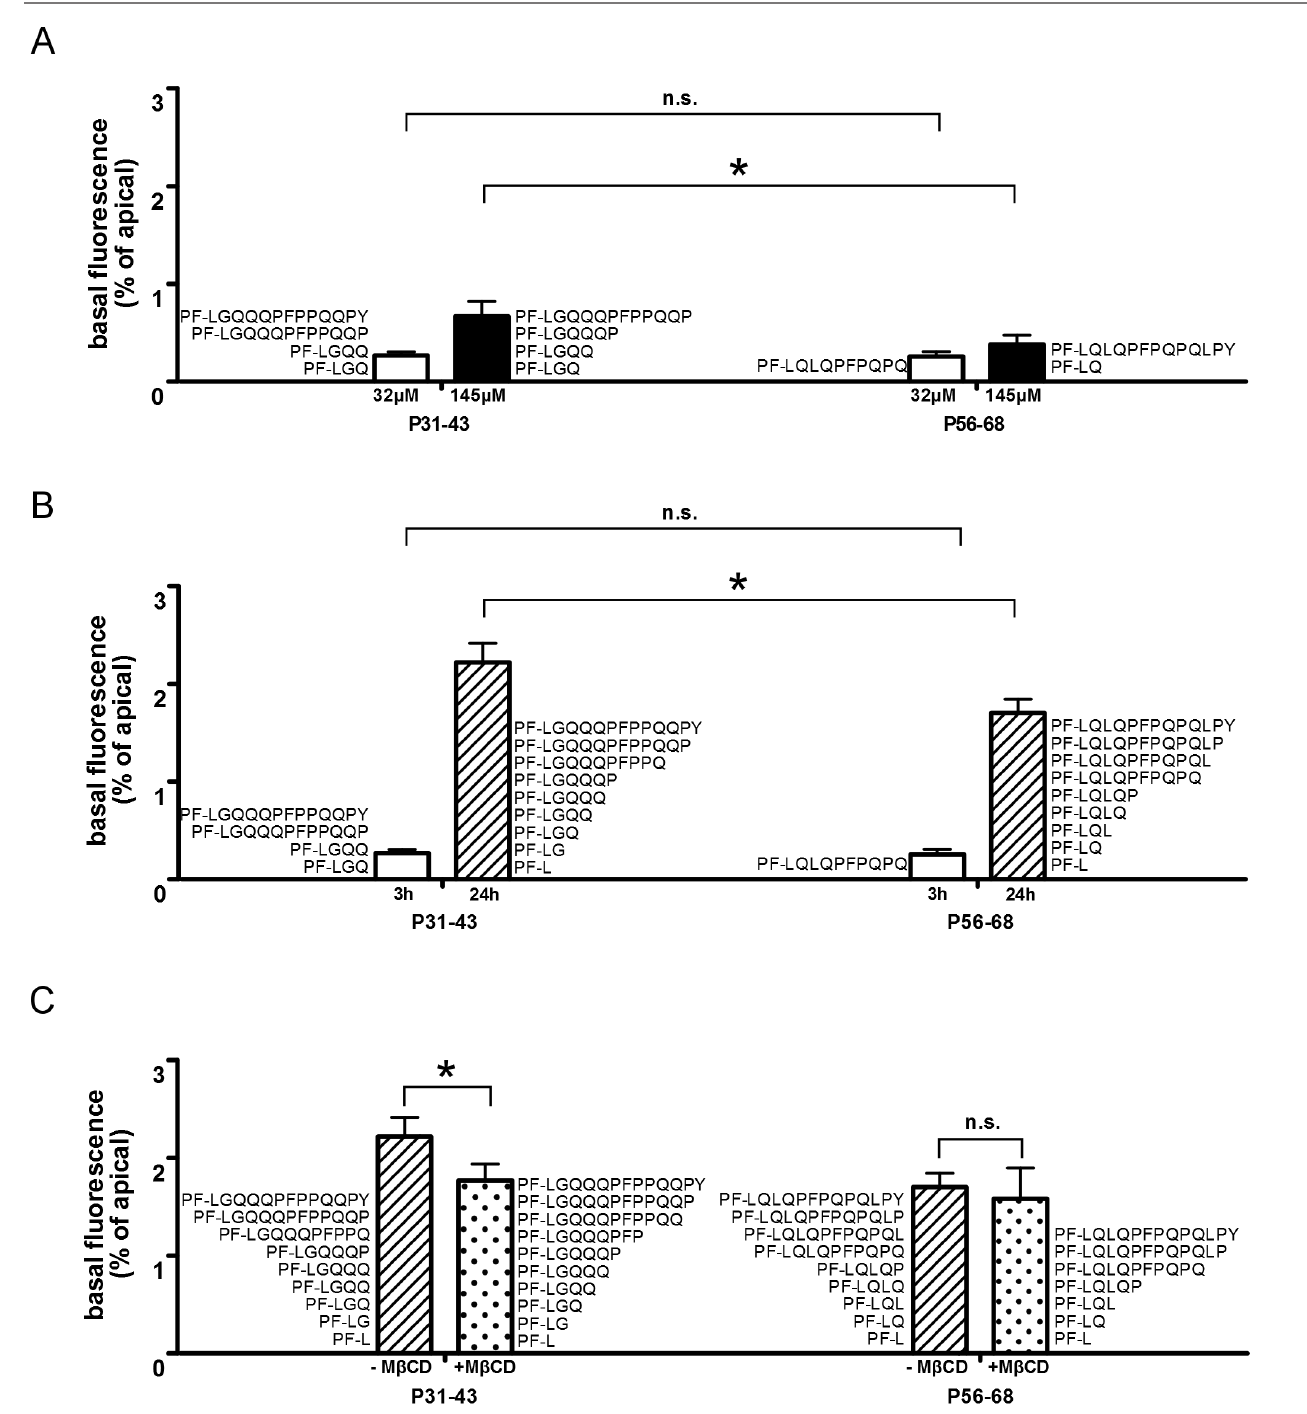
Figure 2. Epithelial translocation in Caco-2 monolayers of fluorescence labeled gliadin peptides measured by fluorescence spectroscopy and MALDI-TOF-MS. Fluorescence intensity and mass spectrometric identified peptides in the basal cell culture media (A) after incubation with fluorescence labeled P31–43 and P56–68 (32 m mol/L and 145 m mol/L) for 3 h, (B) after incubation with 32 m mol/L fluorescence labeled P31–43 and P56–68 for 3 h and 24 h, (C) after incubation with 32 m mol/L fluorescence labeled P31–43 and P56–68 with and without M b CD for 24 h. Basal fluorescence is given as % of apical fluorescence intensity. Results are shown as mean ¡ SD; *p , 0.05; n.s.: not significant.